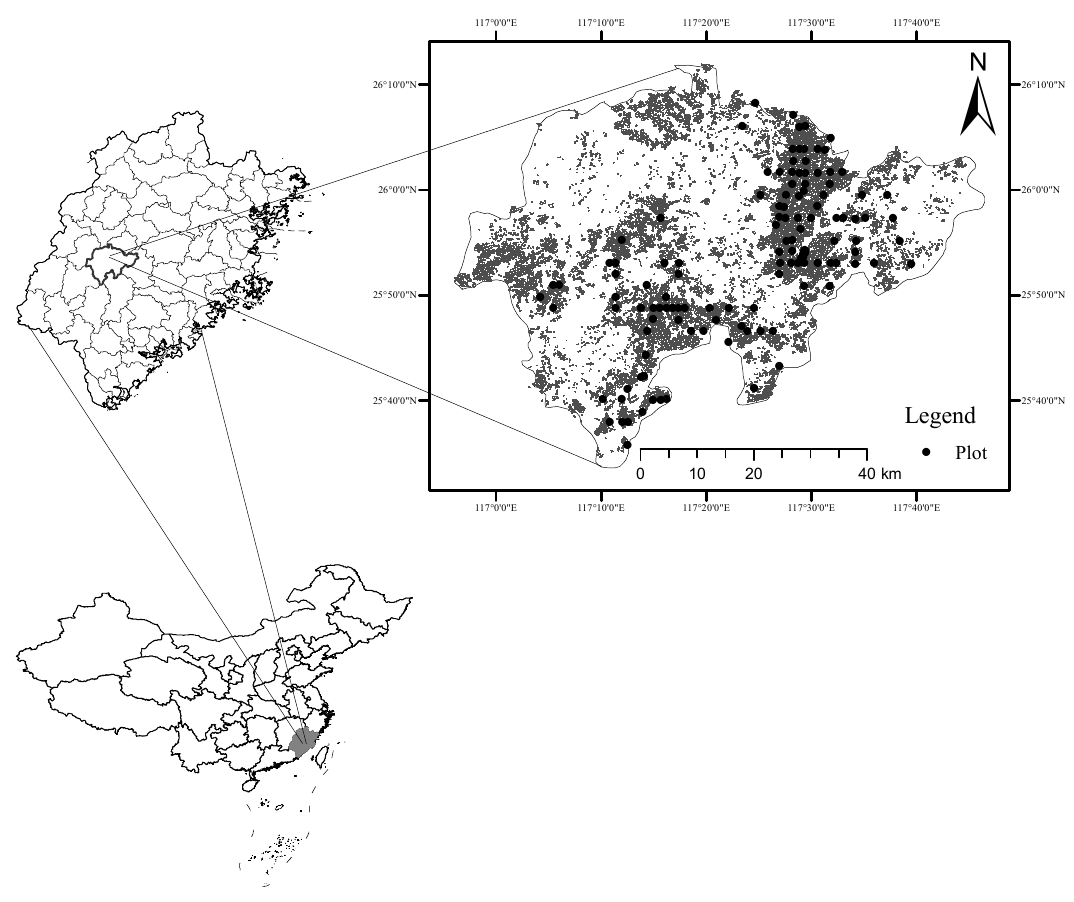
Figure 1. A map of the study area showing the distribution of bamboo forests (polygons) and sampling locations (solid